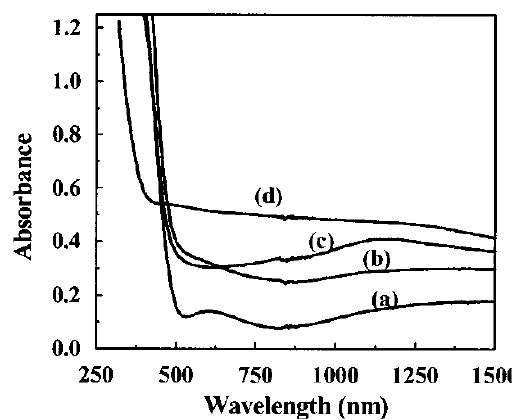
FIGURE 12 Absorptionspectraofspin-coatedV 2 O 5 thinfilmstreatedatvariousappliedpotentials:(a)as-deposited, (b) þ 1200mV, (c) þ 200mVand (d) (cid:3)